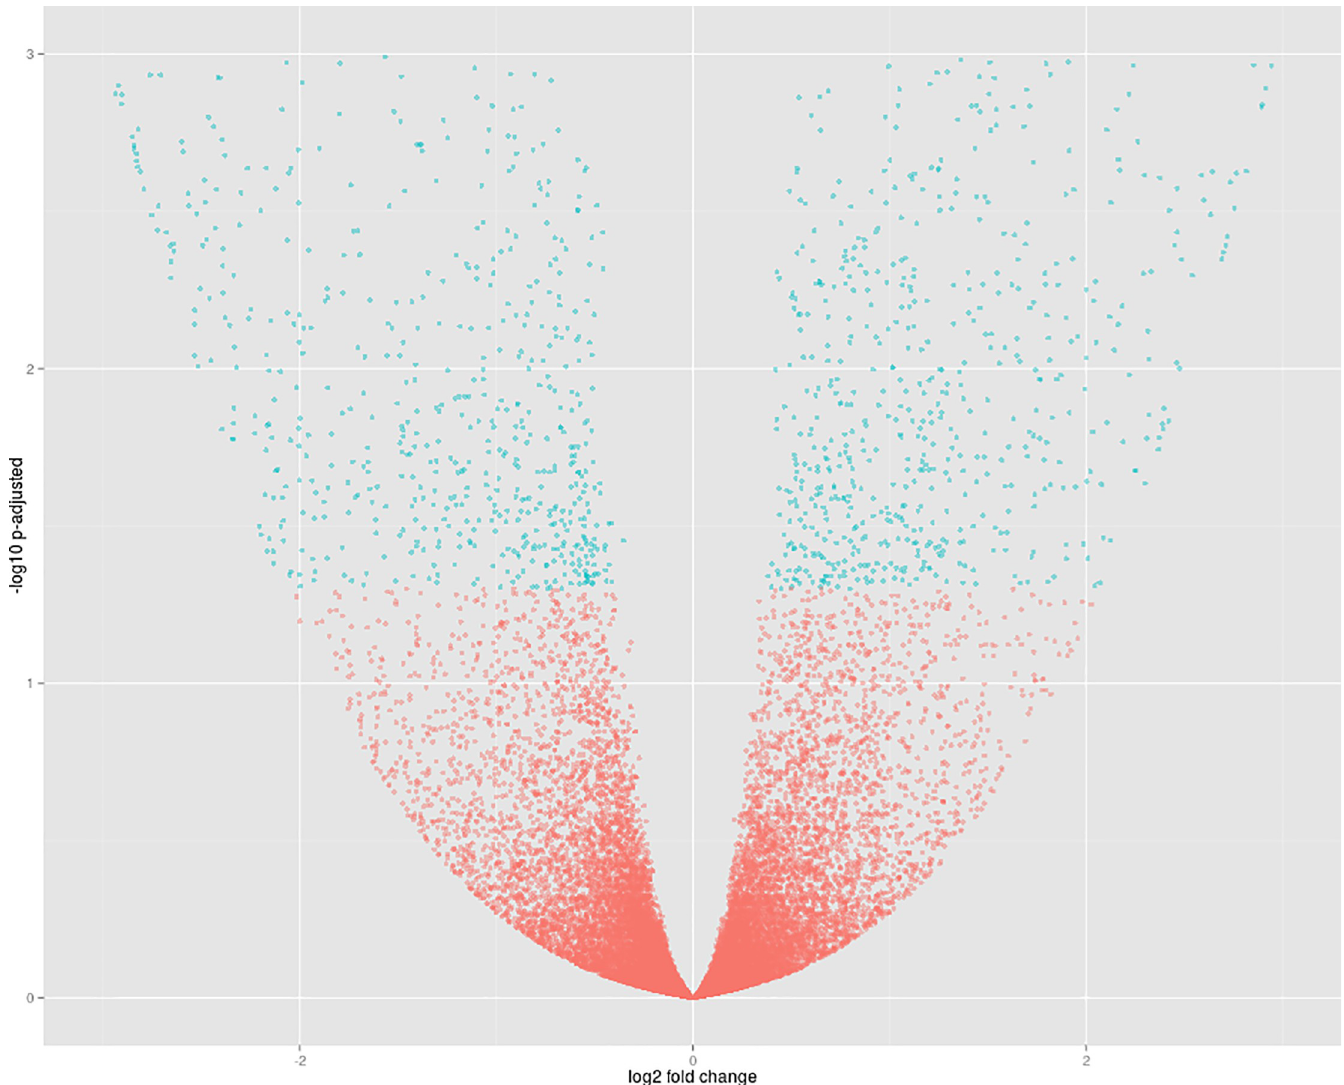
Fig 2. Volcano plot of comparison 2. Dots in blue represent significant differentially expressed genes. The genes of the IAC Imperador genotype (Libraries 7–9) are represented to the left of the origin of the coordinate plane, and the genes of DOR 364 (Libraries 10–12) to the right.